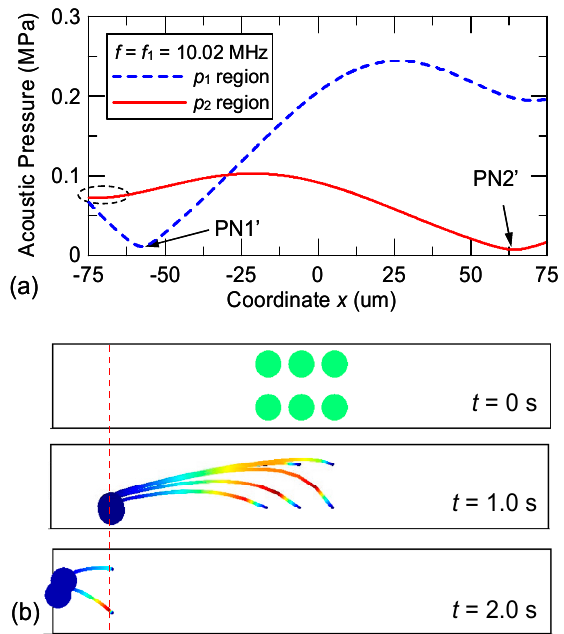
Figure 6. ( a ) Calculated acoustic pressure variations and ( b ) particle trajectories in the design of the series IDTs using the input frequency f 1 = 10.02 MHz in the p 1 and p 2 regions.